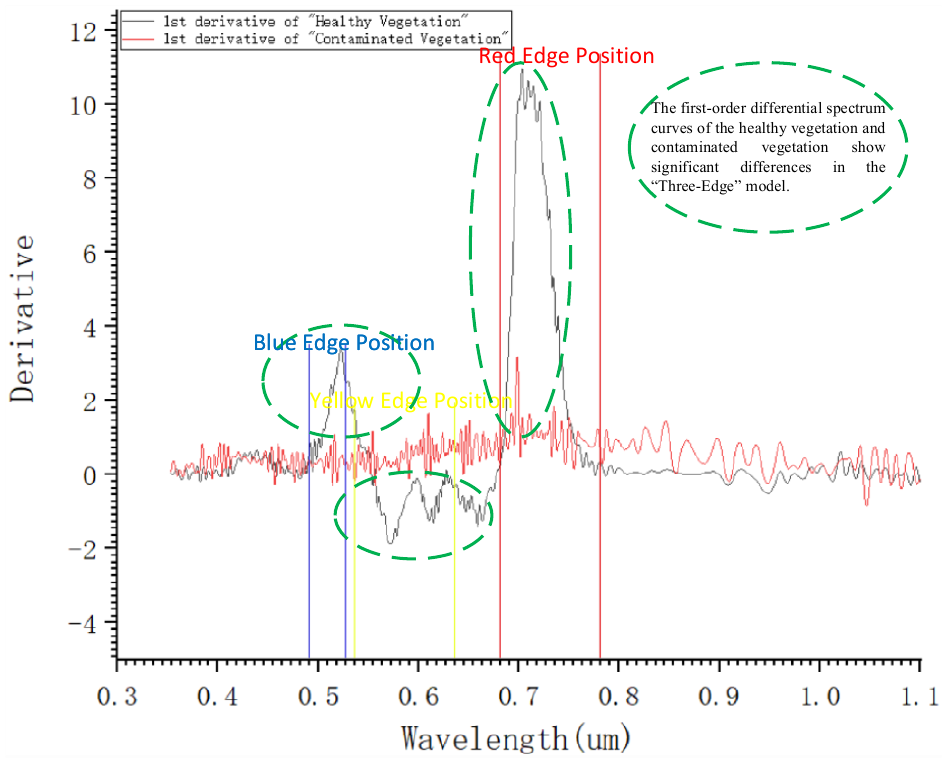
Figure 2. First-order differential spectrum curves of healthy and impacted vegetation based on the “Three-Edge” model (note: original spectrum data used to draw the figure are derived from the Jet Propulsion Laboratory, USA [72,73] ).